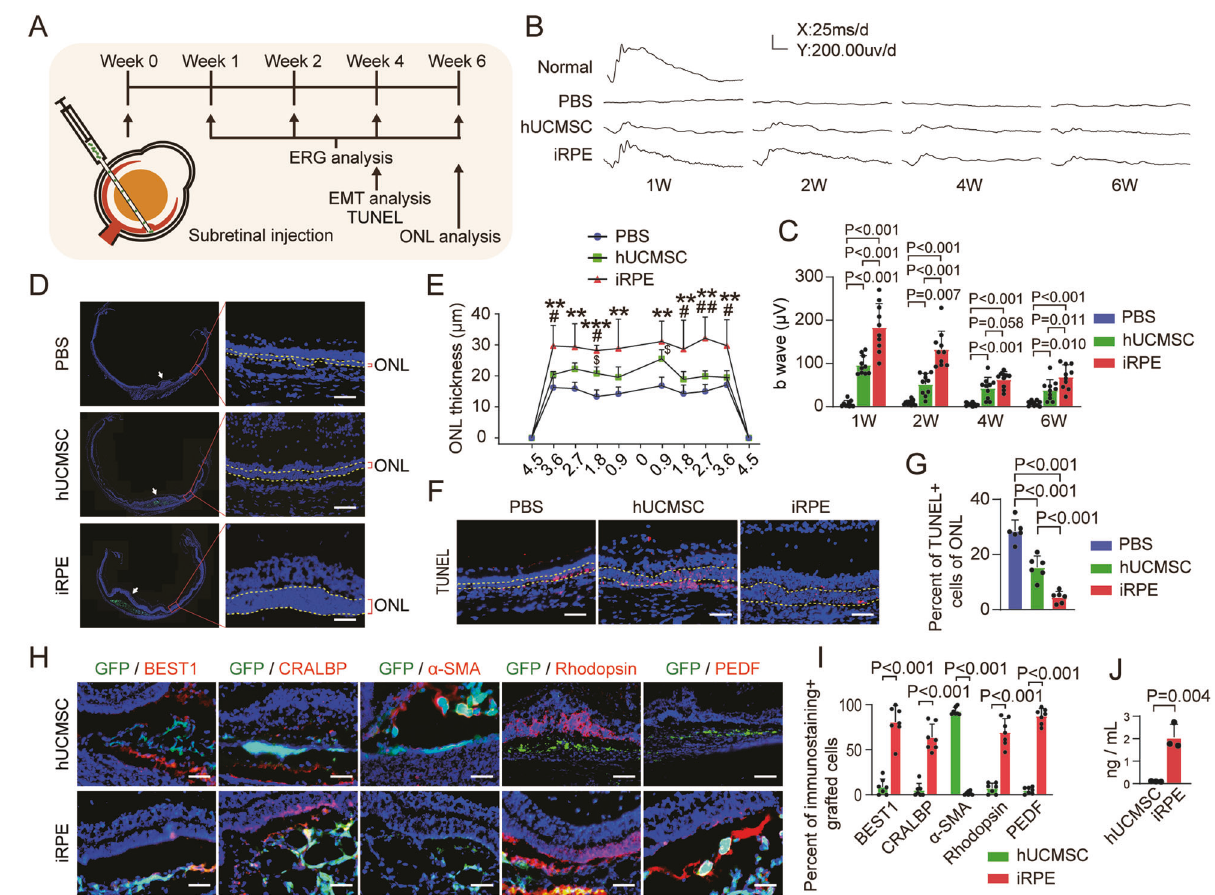
Fig. 7 iRPE cells delay retinal degeneration in rat AMD model. A Experiment design for iRPE transplantation in SI-induced rat AMD model. B ERG waveforms recorded at different time points (the calibration indicates 200 μ V vertically and 25 ms horizontally). C Quantitative analysis of ERG b-wave amplitude ( n = 10, P value measured by one-way ANOVA and post hoc Bonferroni ’ s test). D Representative micrographs of retinal samples at week 6 post-transplantation. The injection sites were pointed by arrows, and ONL was between yellow dashed lines. E Quantitative analysis of ONL thickness ( μ m) ( n = 6, P value measured by one-way ANOVA and post hoc Bonferroni ’ s test). F Representative micrographs of retinal cryosections stained with TUNEL. G Statistical analysis of the percentage of the apoptotic cells in ONL ( n = 6, P value measured by one-way ANOVA and post hoc Bonferroni ’ s test). H Immunostaining of hUCMSCs and iRPE cells after transplantation in vivo for 4 weeks. I Quantitative analysis of percent of immunostaining + cells of grafted cells ( n = 7, P value measured by Student ’ s unpaired t test). J The level of PEDF secreted by hUCMSCs and iRPE cells were determined by ELISA ( n = 4, P value measured by Student ’ s unpaired t test). Scale bar = 50 μ m. Results are expressed as mean ± SD; ** P < 0.01, *** P < 0.001, compared with PBS group; # P < 0.05, ## P < 0.01 compared with hUCMSC group; $ P < 0.05 compared with PBS